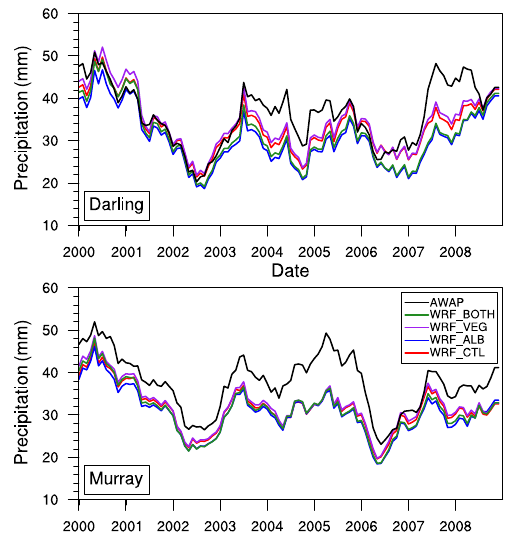
Figure 6. The difference in 12-month running average precipitation (mmmonth − 1 ) between each model simulation and WRF_CTL, av- eraged over each river